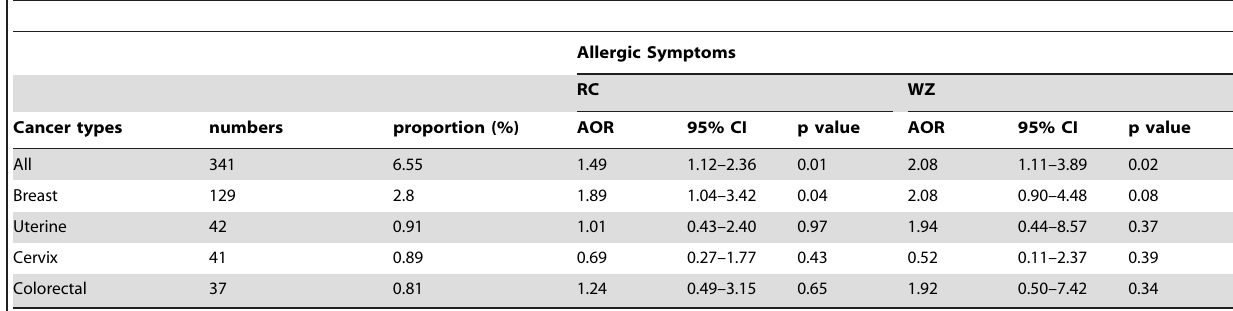
Table 4. Association between cancer subtypes and allergic symptoms among female study